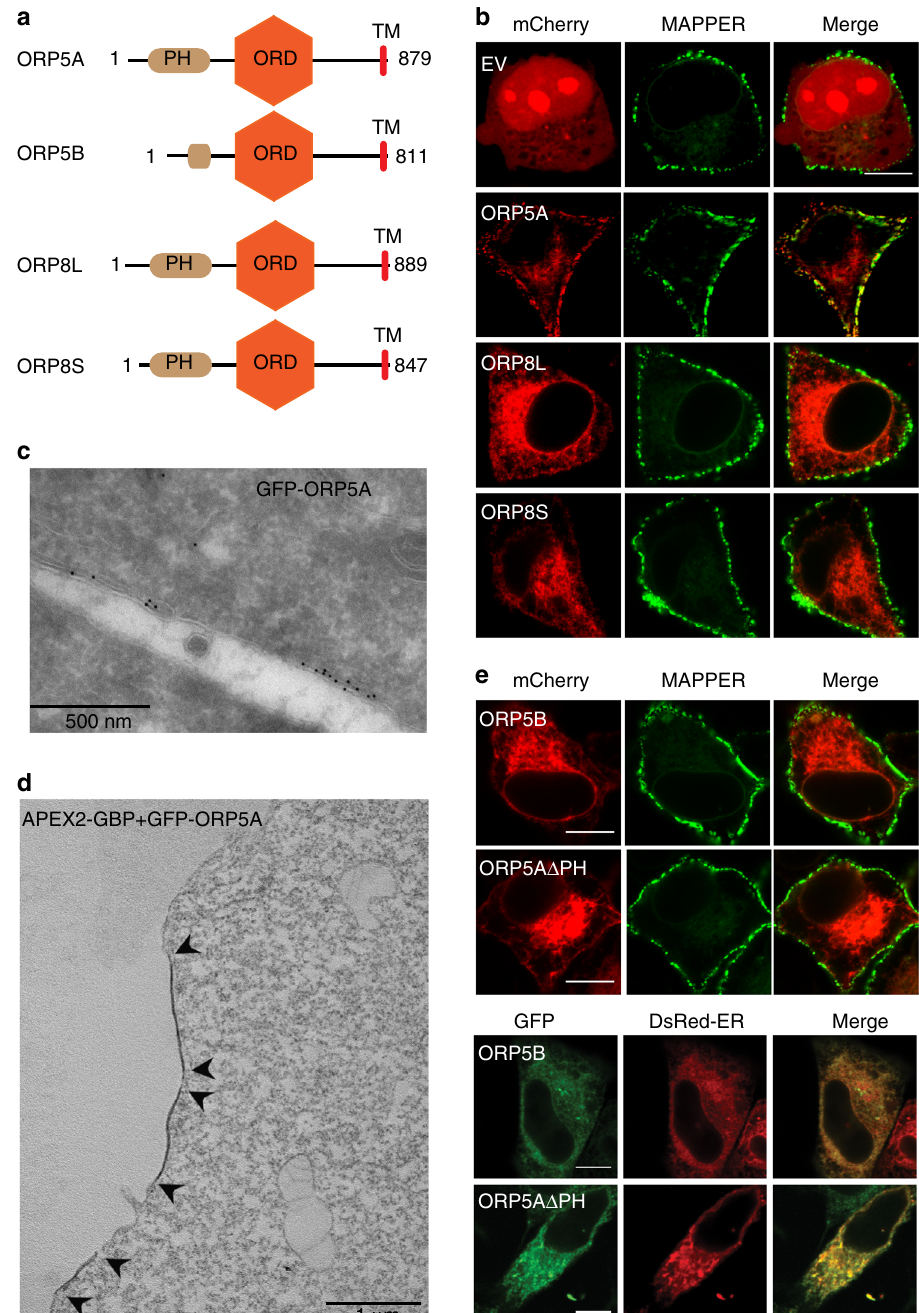
Fig. 1 Recruitment of ER-anchored ORP5 to the ER – PM contact sites. a Schematic representation of the splice variants of human ORP5 and ORP8. b Co-localization of mCherry empty vector (EV) or mCherry-tagged ORP5A, ORP8 long form (ORP8L), and the shorter variant of ORP8 (ORP8S) with MAPPER (ER – PM junction marker protein) in HeLa cells. Bar = 10 μ m. c Immunoelectron microscopy of HeLa cells expressing GFP – ORP5A highlighting the labeling of electron dense gold particles at close appositions between the ER and PM. Primary antibody against GFP was used. Bar = 500 nm. d EM imaging of HeLa cells expressing APEX – ORP5A, arrows highlighting electron dense domain due to ORP5A labeling at the ER – PM junction. Bar = 1 μ m. e Co-localization of mCherry-tagged ORP5B (variant with a truncated PH domain) and PH domain null ORP5A with MAPPER, and GFP-tagged ORP5B and ORP5A PH domain deletion construct with DsRed-ER marker demonstrating the importance of PH domain for ER – PM junctional recruitment. Bar = 10 μ